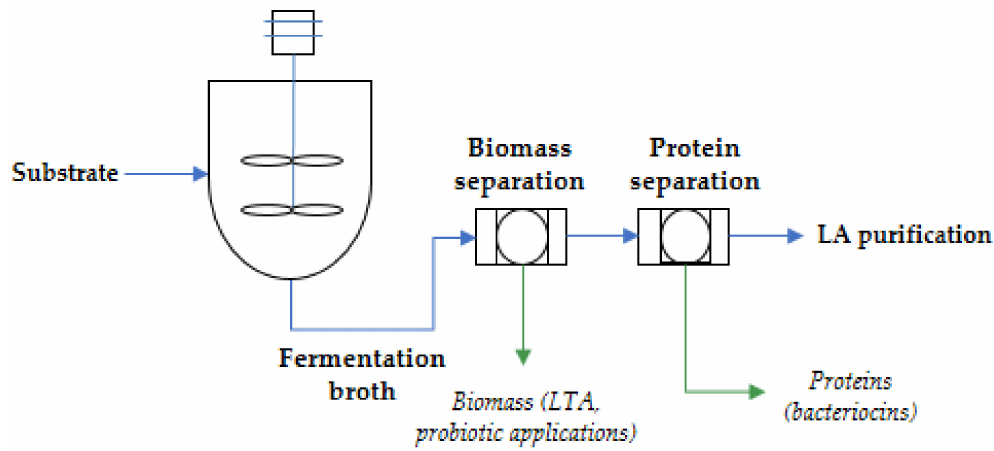
Figure 3. Potential process flow diagram for of a multi-product LAB based process (adapted from Reference [147] licensed under CC BY-NC 4.0 available at https: // doi.org / 10.1016 /